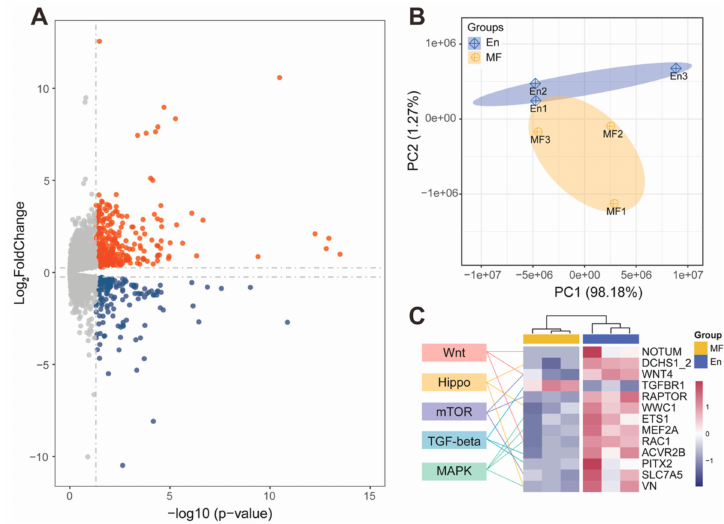
Figure 5. Transcriptome profile of En and MF bees. ( A ) 8925 genes were detected in the RNA sequencing results, with 285 genes significantly up-regulated (red) and 146 down-regulated (blue) in En bee hindgut compared to MF. ( B ) The gene expression profiles of En and MF bee hindgut were clearly separated in the PCA analysis. ( C ) Heatmap of developmental differentially expressed genes (FPKM). Genes involved in Wnt, Hippo, mTOR, TGF-beta, and MAPK developmental signaling pathways were significantly up-regulated in En bees, except the gene TGF-beta receptor type-1 (TGFBR1). En: E. faecium H7 colonized; MF: